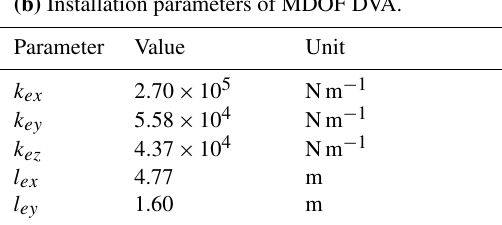
(b) Installation parameters of MDOF